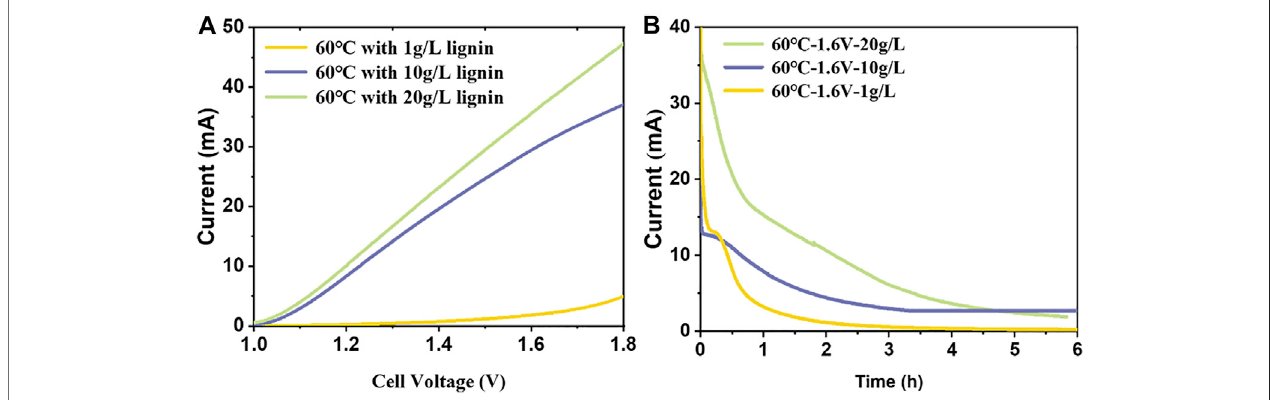
FIGURE 5 | The in fl uence of lignin concentration on LAWE: (A) LSV curves, with a scan rate of 5 mV/s; (B) I-t curves. 60 ° C with different lignin concentrations. Solution: 1 mol/L NaOH.